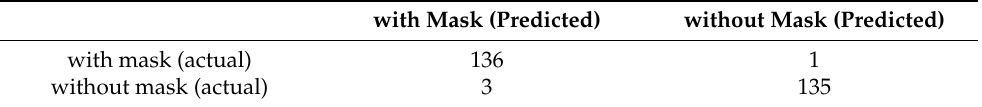
Table 3. Confusion matrix of the